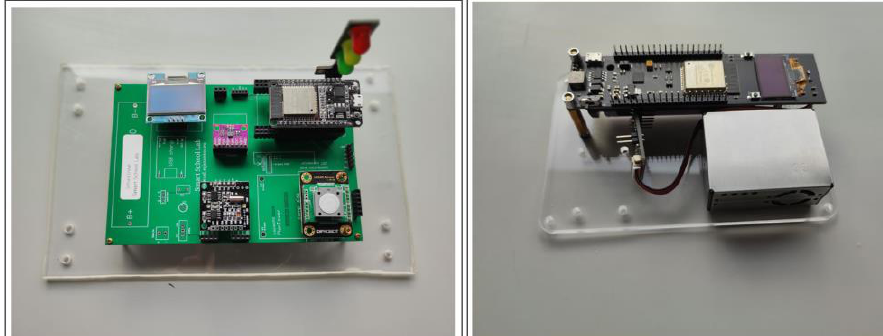
Figure 20. BikeTrack app.